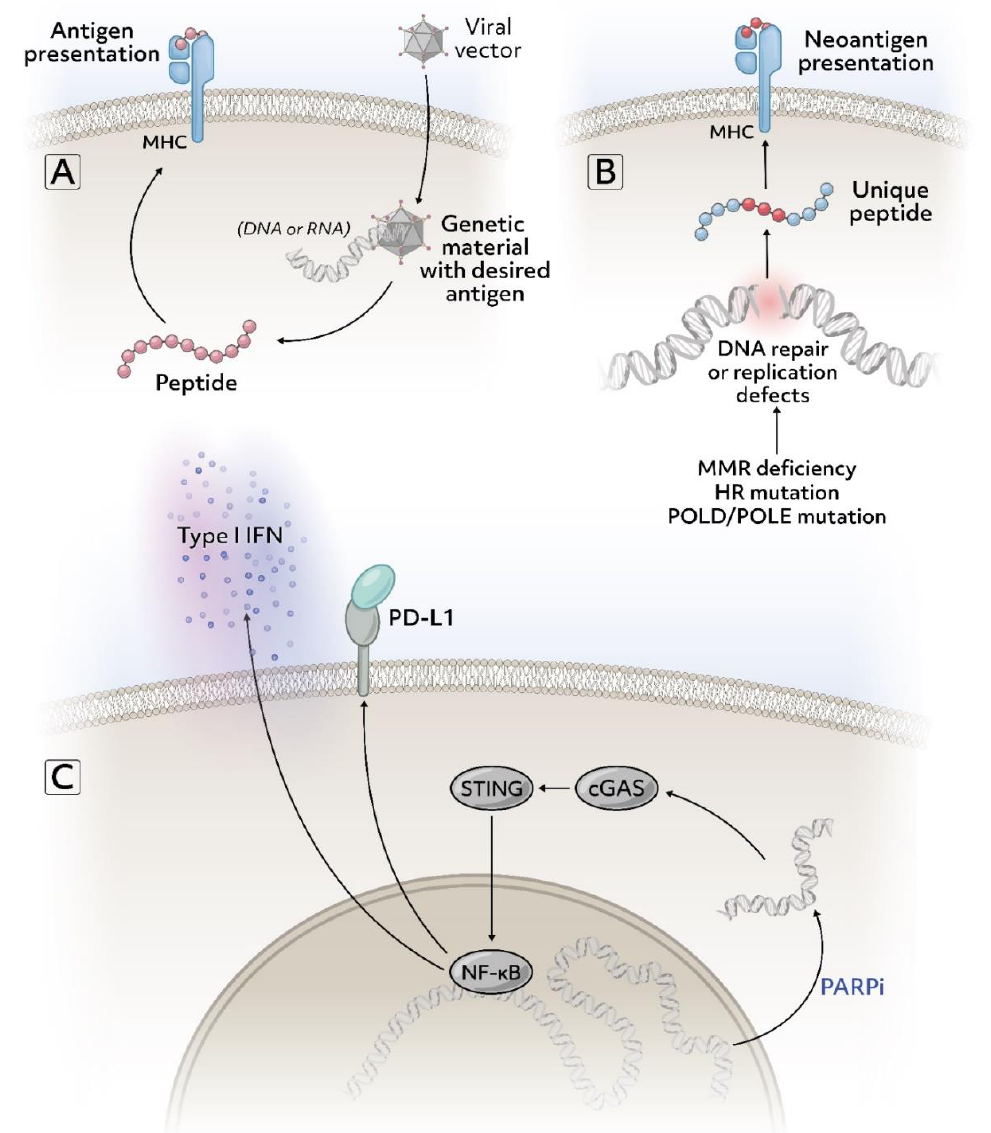
Figure 1. Select mechanisms to target immune pathways in prostate cancer ( A ) Viral vector from a vaccine containing a sequence for antigen presentation such as prostate-specific antigen or other targets that may be enriched in prostate cancer. ( B ) Many mutations commonly found in prostate cancer cause DNA repair deficiency or replication defects and lead to more mutations. If these mutations result in changes to the amino acid sequence of a protein, they can serve as potential tumor-specific neoantigens. ( C ) Treatment with poly-ADP (ribose) polymerase inhibitors (PARPis) can cause DNA to leak into the cytoplasm and trigger the cGAS-STING pathway which can induce an immunostimulatory response. Figure created via Adobe Inc. (2021). Adobe Illustrator version 25.2.3. Retrieved from https://adobe.com/products/illustrator (accessed on 11 April